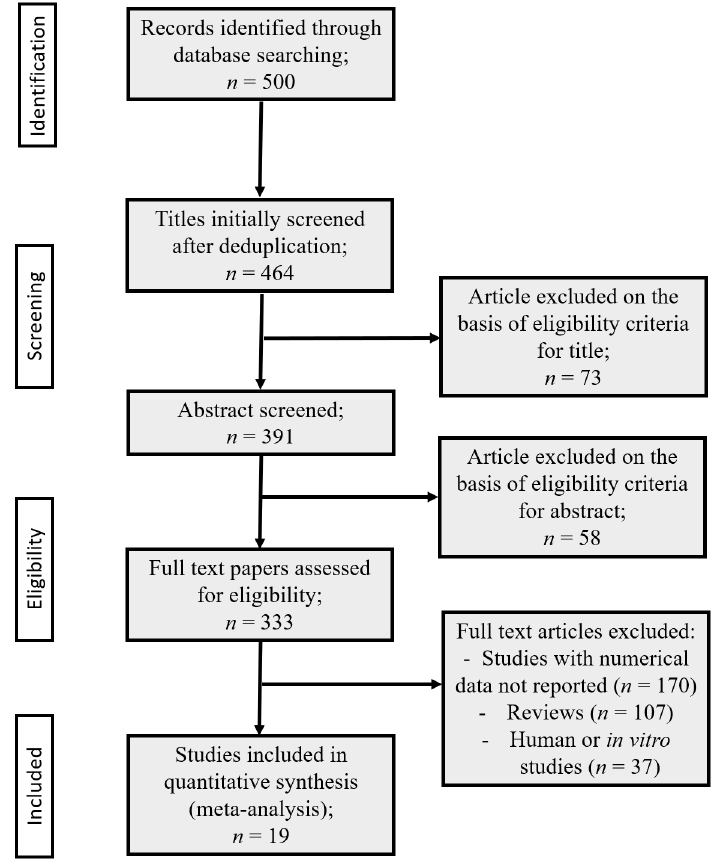
Figure 3. PRISMA flow chart .